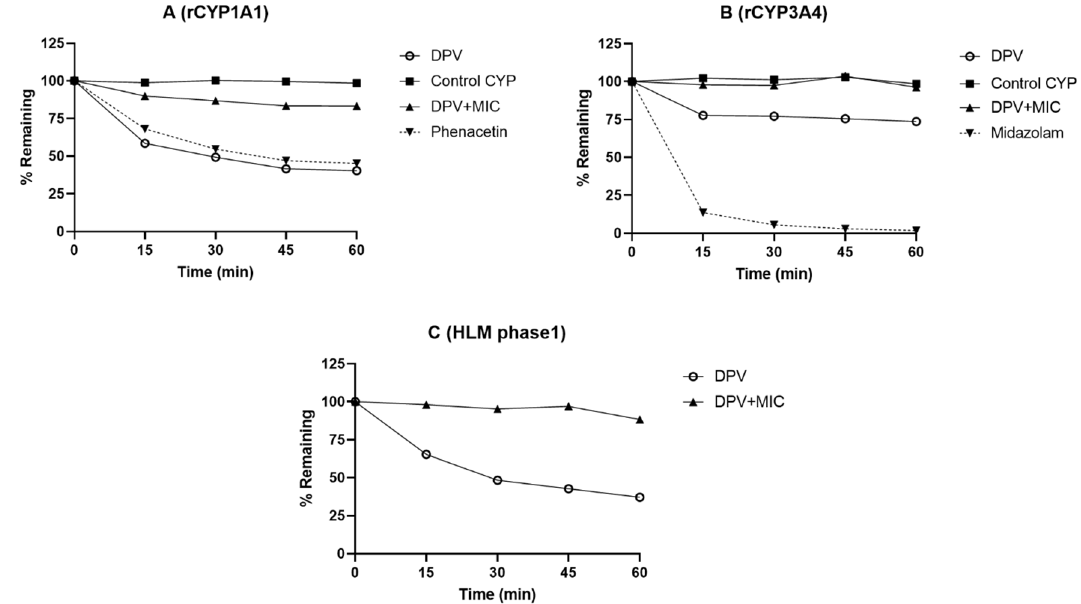
Figure 1. Metabolism of DPV using reaction phenotyping in ( A ) rCYP1A1, ( B ) rCYP3A4 and ( C ) HLM (phase 1) enzymes. For these enzymes, DPV metabolism was also evaluated in the presence of MIC. Each test compound/substrate was incubated in a separate incubation mixture. Data are shown as the mean of two biological replicates.